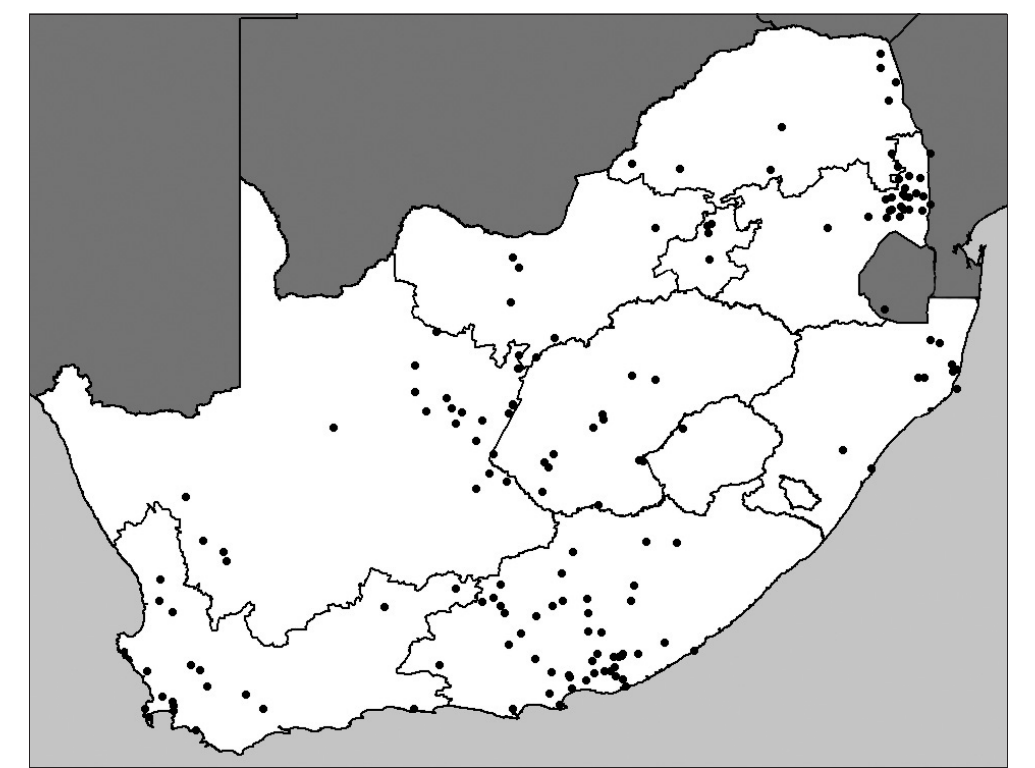
The geographic distribution of Amblyomma marmoreum within the borders of South